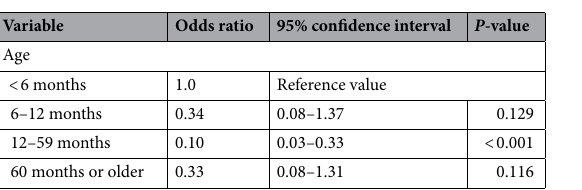
Table 4. Univariable logistic regression of the association between age and